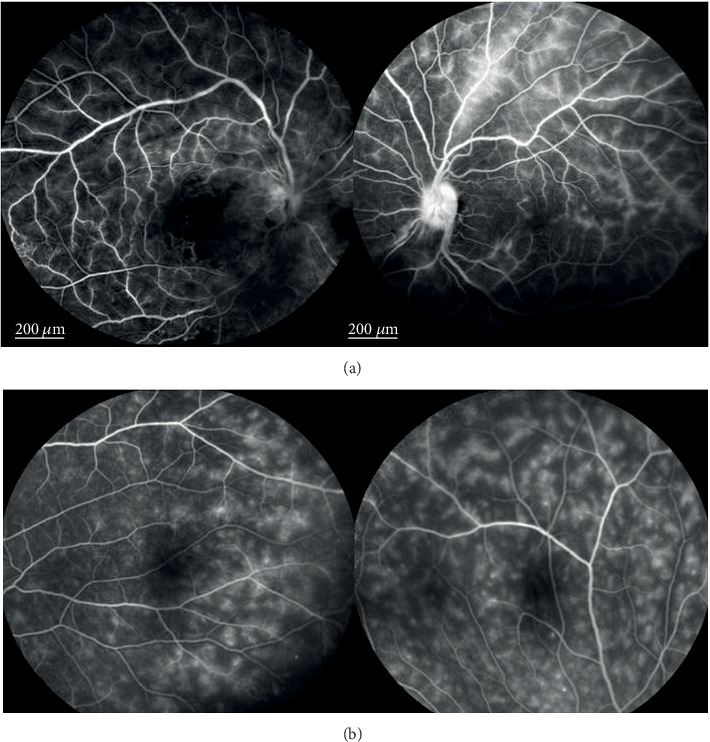
Fluorescein angiography (FA) findings in a patient with severe retinal vasculitis; (a) late-phase FA showing optic disc and vascular leakage and areas of nonperfusion in a Behçet's syndrome (BS) patient with a bilateral severe occlusive vasculitis; (b) late-phase FA in a patient with active bilateral retinal vasculitis affected by BS. All retinal peripheral quadrants of both eyes of this patient showed the same diffuse fern-like capillary leakage, the most frequent FA finding for Behçet's uveitis.